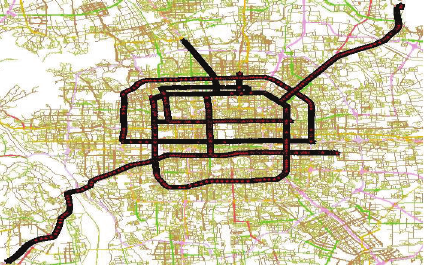
Figure 2: The test road network in Beijing. Table 1: The data sample sizes for different road types.